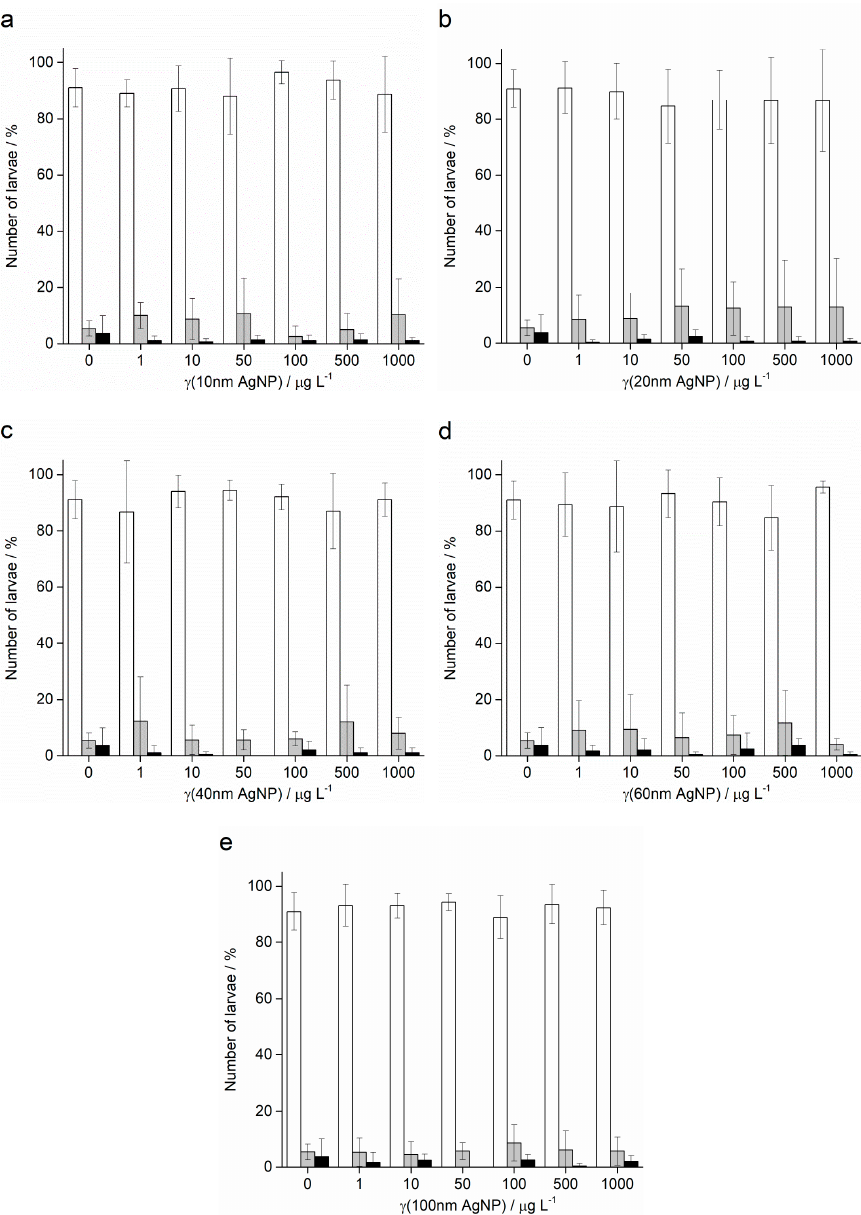
Figure 9. Offspring quality of urchin P. lividus whose sperm was pre-treated for 1 h with different sizes of AgNPs: ( a ) 10 nm, ( b ) 20 nm, ( c ) 40 nm, ( d ) 60 nm and ( e ) 100 nm. White columns indicate normally developed larvae and gray columns developmentally delayed or defective larvae, while black columns show embryos with arrested development (± SD).